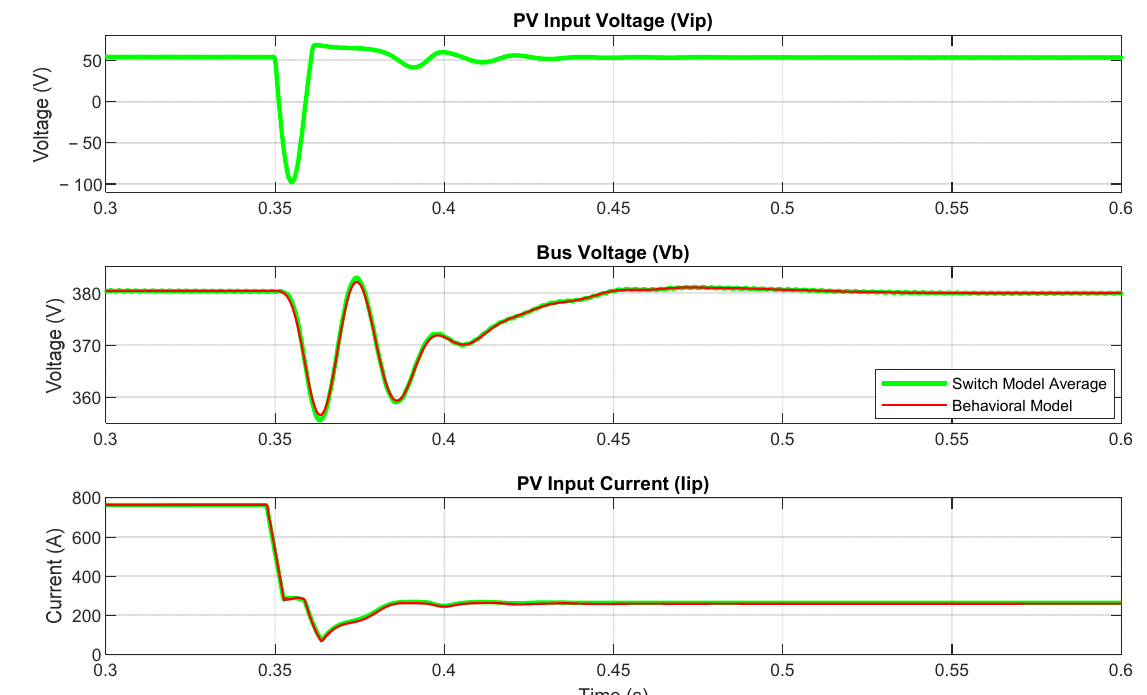
Figure 11. Bus voltage and PV input current waveforms comparison for step change in PV input voltage.